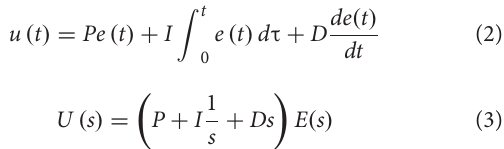
FIGURE 4 | Simulation model of the entire RC structure for the RTHS test. (A) Correspondence of actual RC column specimen for the entire-length column. (B) Configuration of the entire RC frame model.